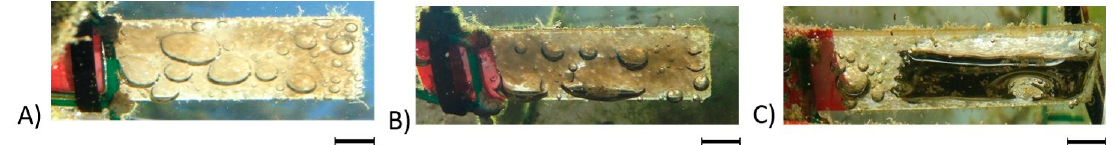
Figure 5. Pictures acquired at day 10 of immersion relative with different surface roughness: ( A ) Sa = 1.67 µ m, ( B ) Sa = 1.95 µ m, ( C ) Sa = 2.92 µ m. Scale bar under each sample is 10 mm.